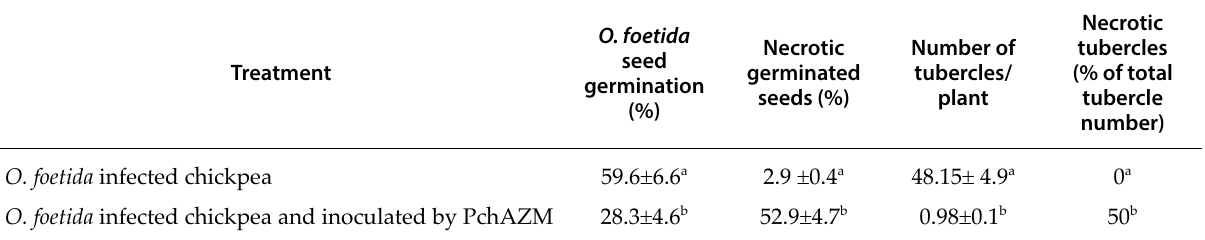
Table 2. Orobanche foetida germination and tubercle formation in co-culture experiments on chickpea roots in relation to rhizobia